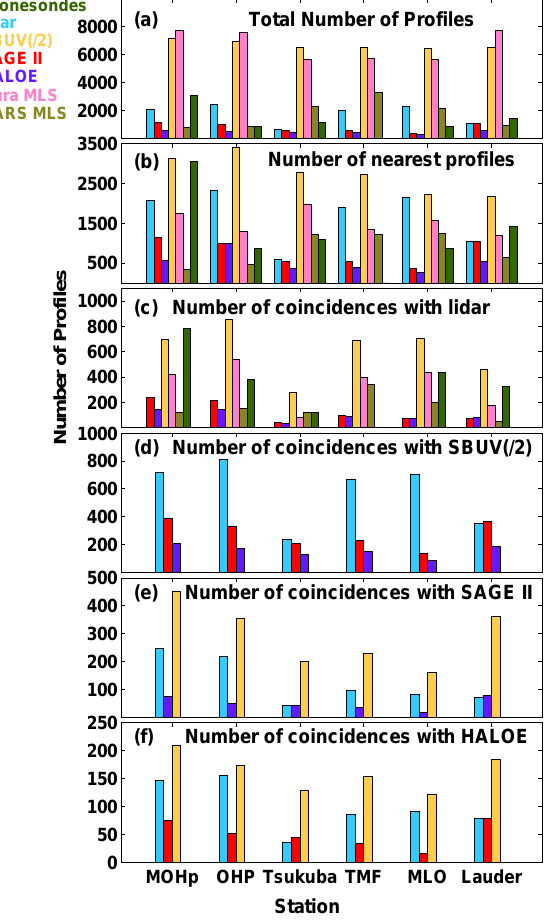
Fig. 1. (a) Total number of profiles of all data sets at various sta- tions, (b) the total number of profiles considering one measurement per day, (c) the total number of coincidences of different observa- tions with lidar, and the total number of coincidences of the long- term measurements (lidar, SBUV(/2), SAGE II and HALOE) with (d) SBUV(/2), (e) SAGE II and (f) HALOE as